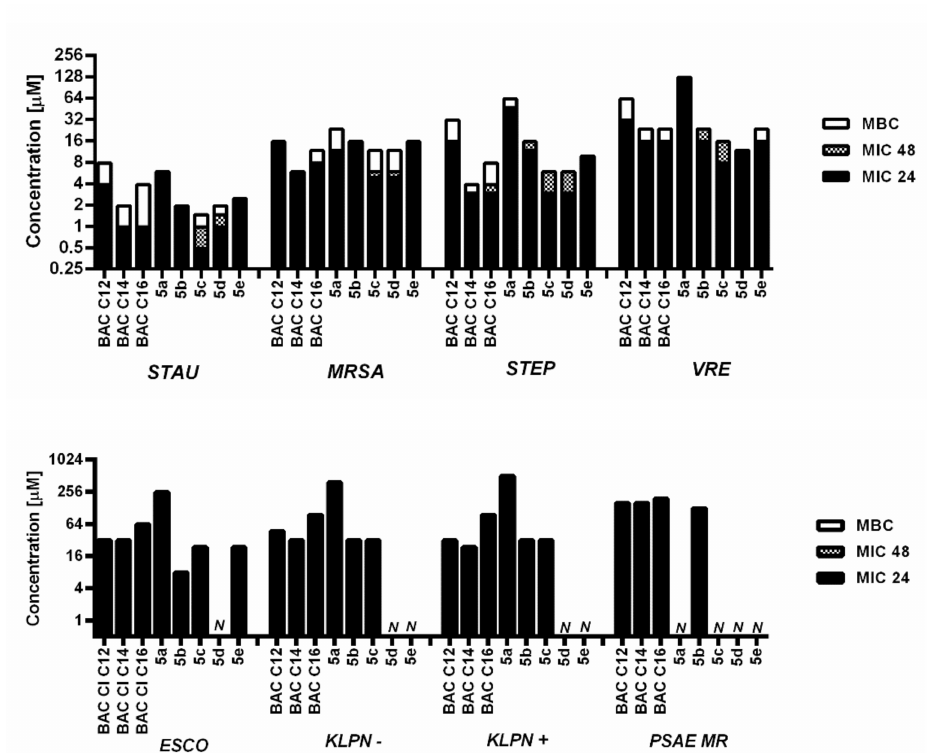
Figure 4. MIC and MBC values of tested compounds for G+ and G- bacterial strains. MIC values were determined after 24 and 48 h of incubation, MBC was determined after 24 h of incubation. The results for BACs had been published elsewhere [31,38]. N means that MIC or MBC was higher than the highest soluble concentration of the compound. Abbreviations: STAU = S. aureus , MRSA = methicillin-resistant S. aureus , STEP = S. epidermidis , VRE = vancomycin-resistant Enterococcus, ESCO = E. coli, KLPN- = K. pneumoniae, KLPN+ = extended-spectrum β -lactamase-producing K. pneumoniae , PSAE MR = multidrug-resistant P. aeruginosa